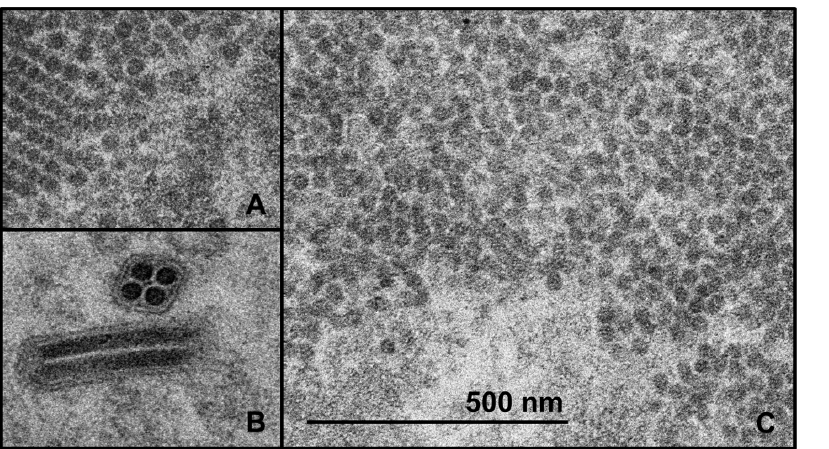
Figure 2. Transmission electron microscopy (TEM) images of thin-sections of AcMNPV-CHIKV37997 infected Sf 21 cells and pV1JNS- CHIKV37997 transfected HEK293 cells. ( A ) Putative CHIKV capsids formed in the cytoplasm of HEK293 cells. Capsid diameters are approximately 30–35 nm. ( B ) Baculovirus showing hallmark multiple nucleocapsids per envelope, with very electron dense nucleocapsids. Nucleocapsid diameter is approximately 40 nm. ( C ) Putative CHIKV capsids formed in the cytoplasm of Sf 21 cells. Capsid diameters are approximately 30–35 nm. Scale bar is equivalent for all images and represents 500 nm.